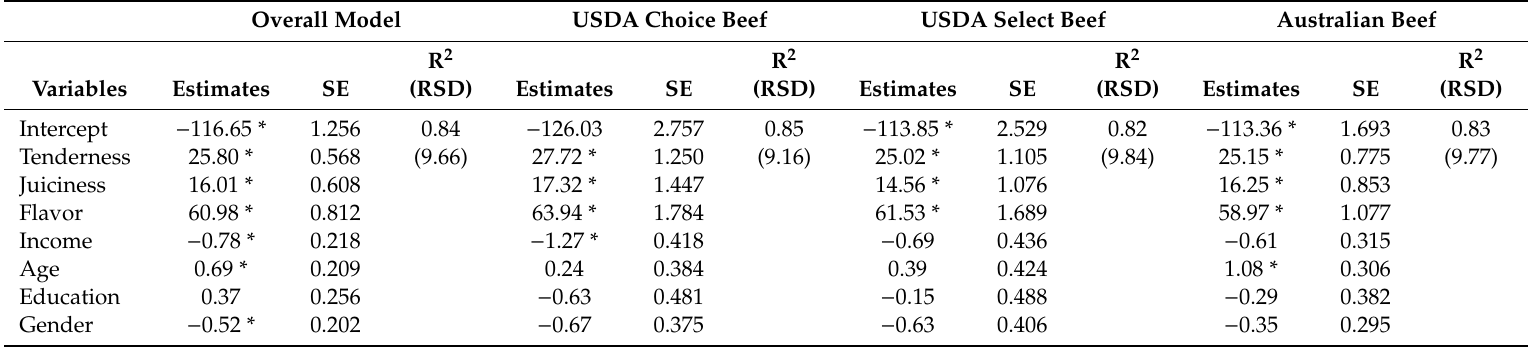
Table 6. Demographic e ff ects on